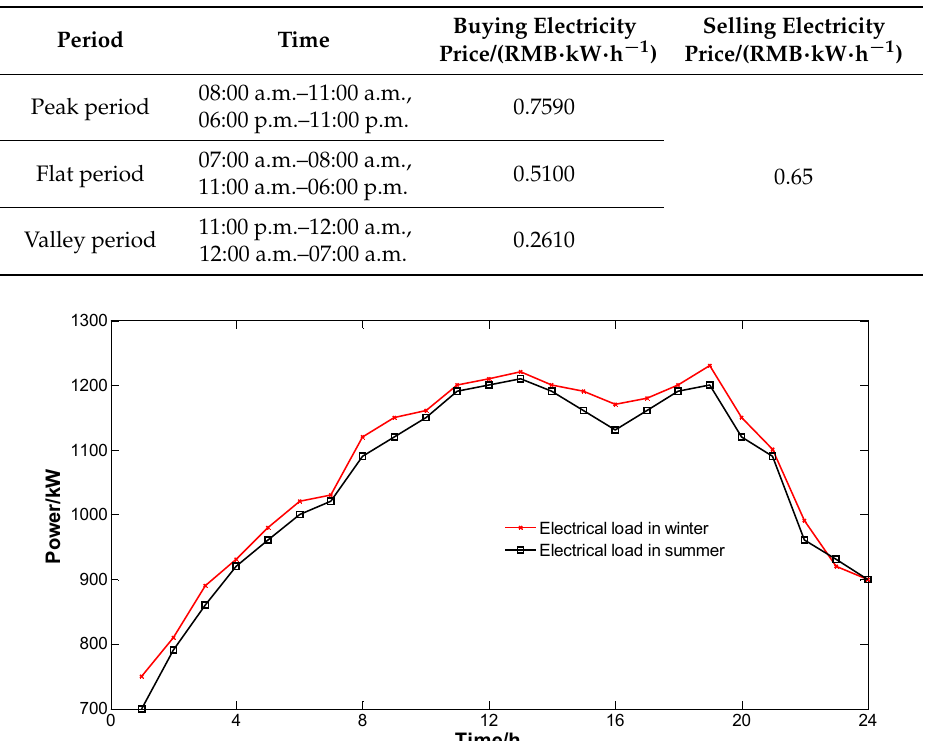
Figure 6. Simulation system. Table 3. Time-of-use electricity prices.